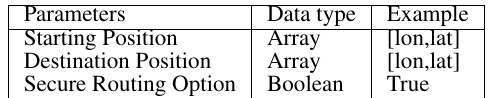
Table 1. User parameter for